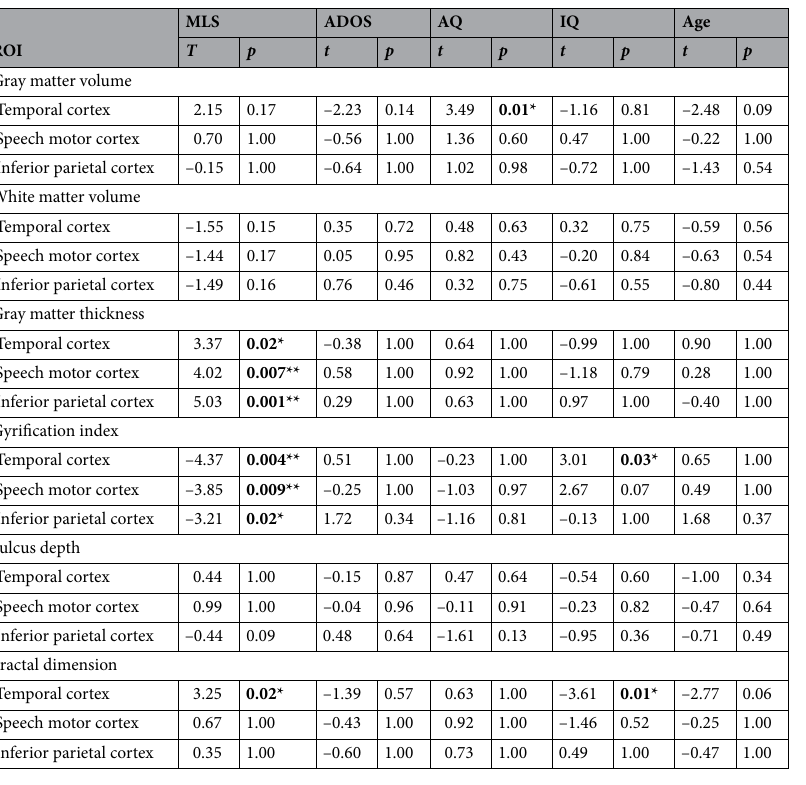
Table 3. The relationships between volume- and surface-based parameters of language-related ROIs and individual characteristics of children with ASD (the results of the models). All p -values, except for the white matter volume models, are Bonferroni-corrected (< 0.05). Significance are labeled with * p < 0.05, ** p < 0.01 and highlighted in